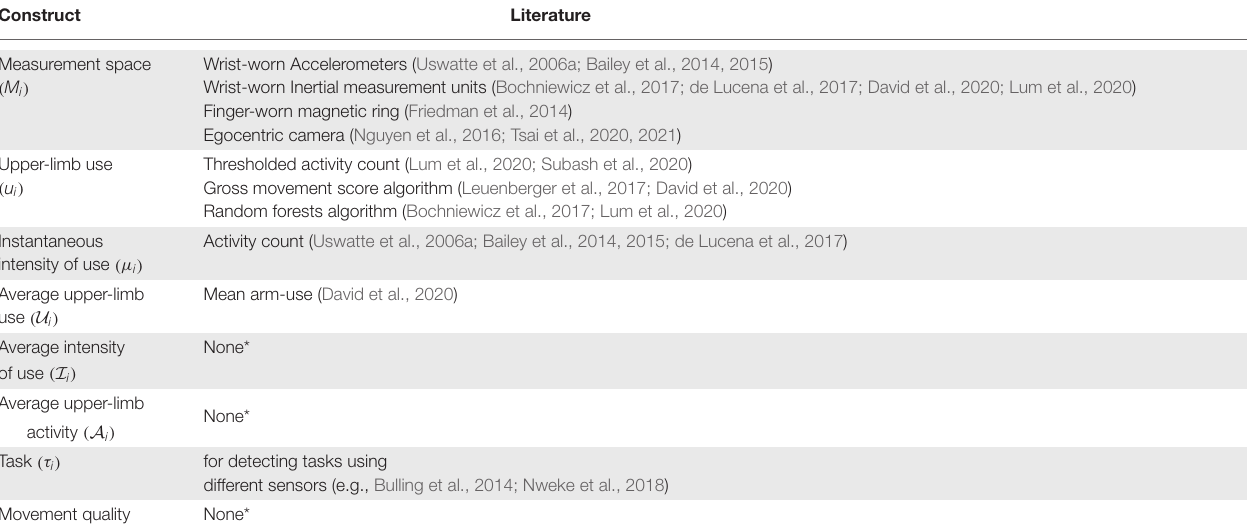
TABLE 1 | List of studies that have implemented measures related to upper limb functioning during free living conditions. Construct